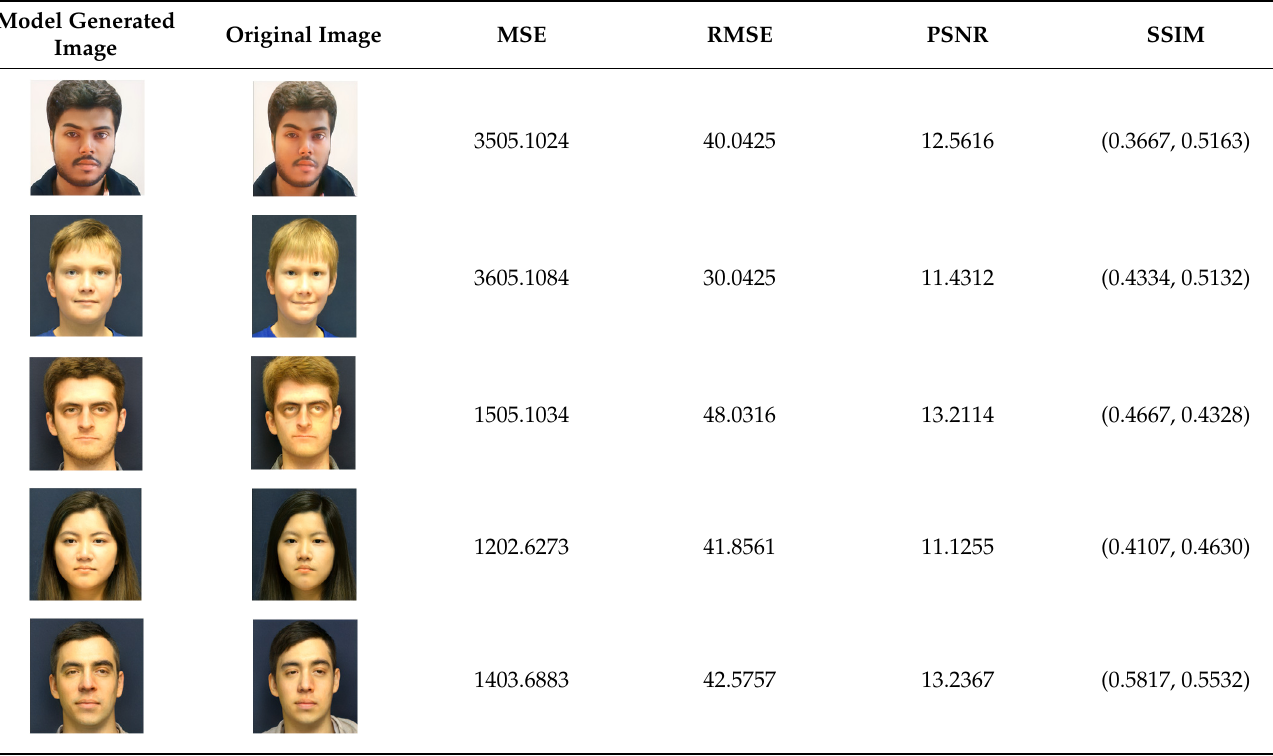
Table 1. MSE, RMSE, PSNR, and SSIM evaluation on real existing persons using the proposed approach. Model Generated Image